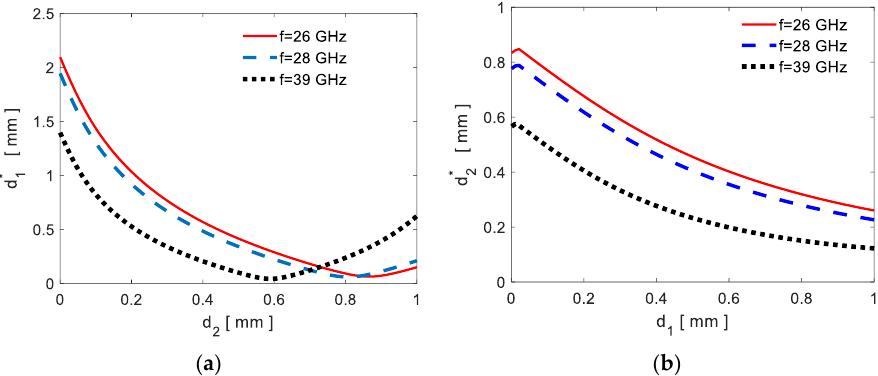
Figure 3. Optimal thickness 𝑑 1∗ as a function of 𝑑 2 ( a ) and optimal thickness 𝑑 2∗ as a function of 𝑑 1 ( b ), computed at the target frequencies of 26 GHz, 28 GHz and 39 GHz.